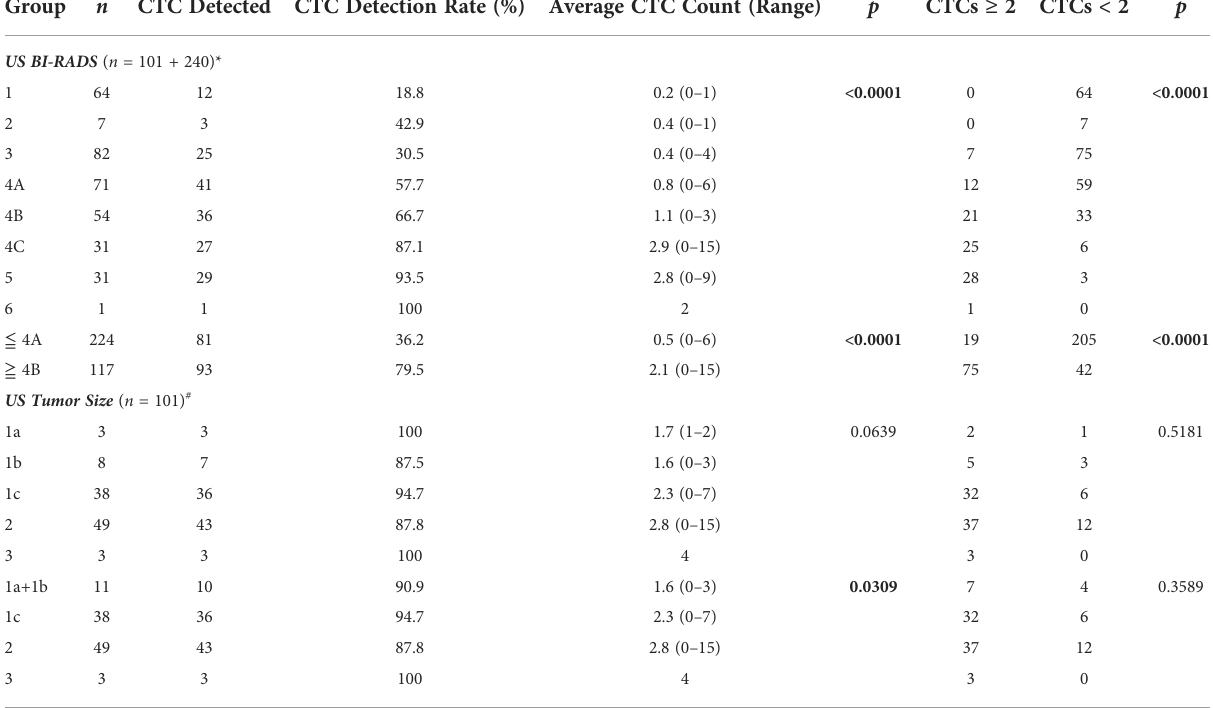
TABLE 3 Correlations of CTC testing and ultrasonography in BC diagnosis.